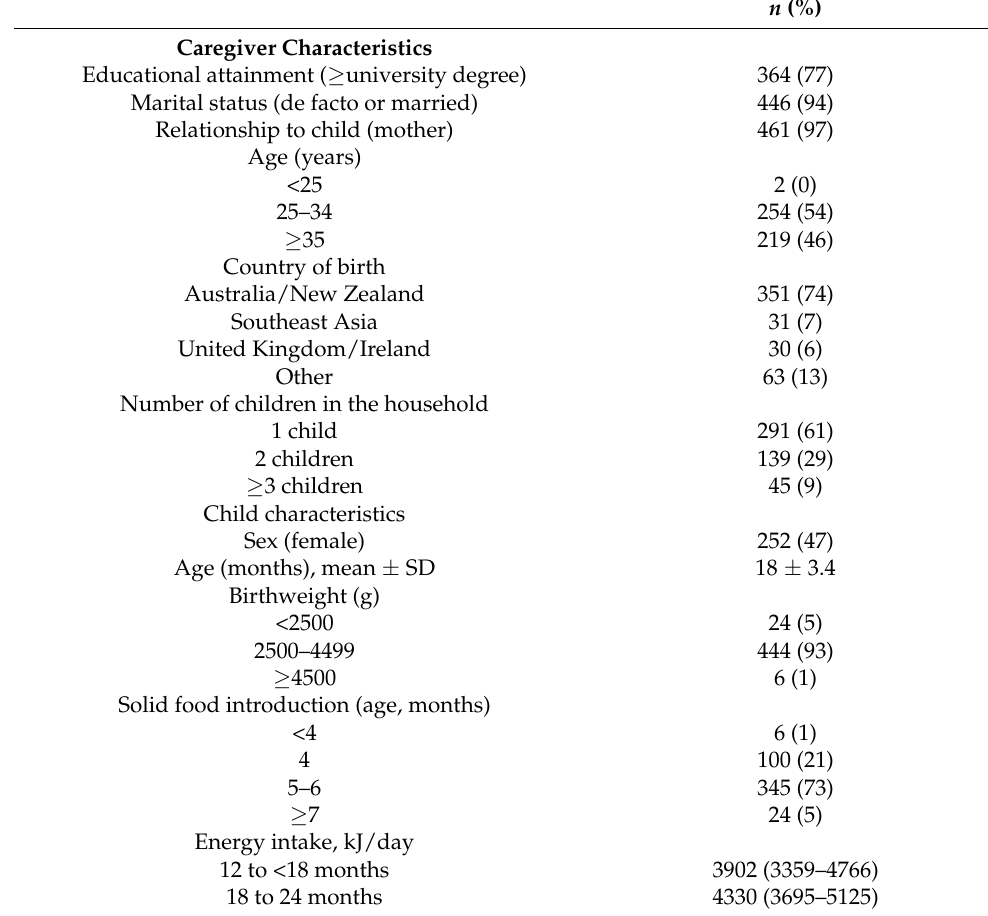
Table 1. Characteristics of caregivers and their toddlers, OzFITS 2021 ( n = 475) 1 .